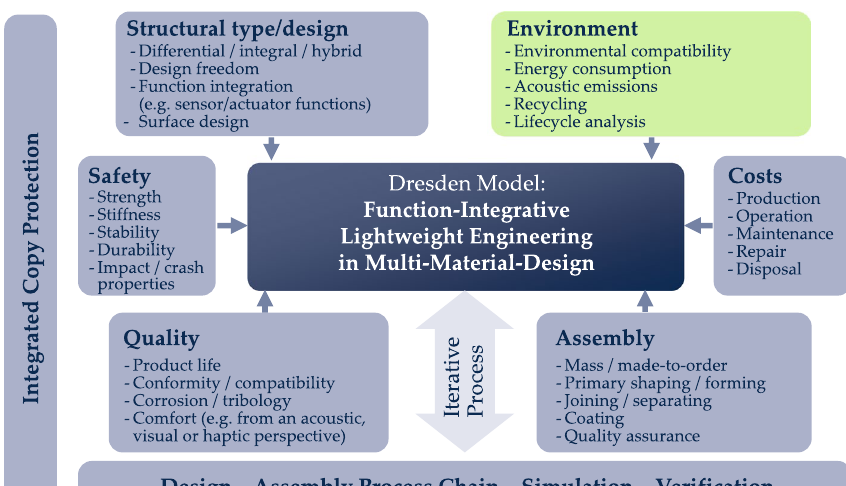
Fig. 1 The 1997 published Dresden Model with its intrin- sic consideration of environ- ment in lightweight design [5]